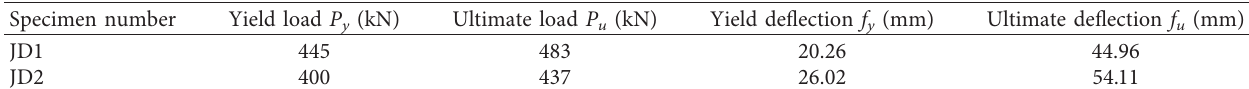
Figure 10: Load-midspan (residual) deflection curves: (a) JD1; (b) JD2. Table 3: Mechanical properties of tested